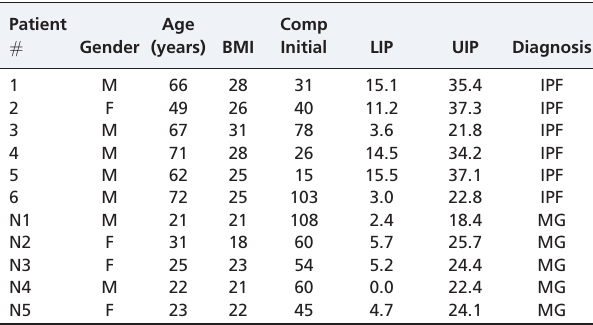
Table 2 - Demographics and mechanical properties of the respiratory system in patients and controls.